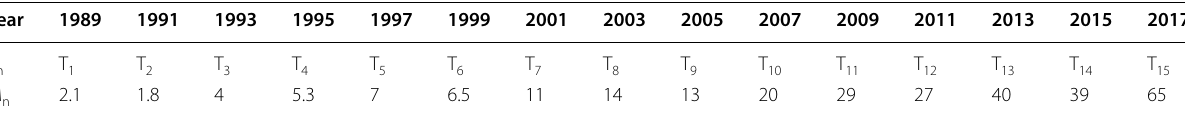
Table 4 The average magnitude of damage from old neighborhoods to the cities